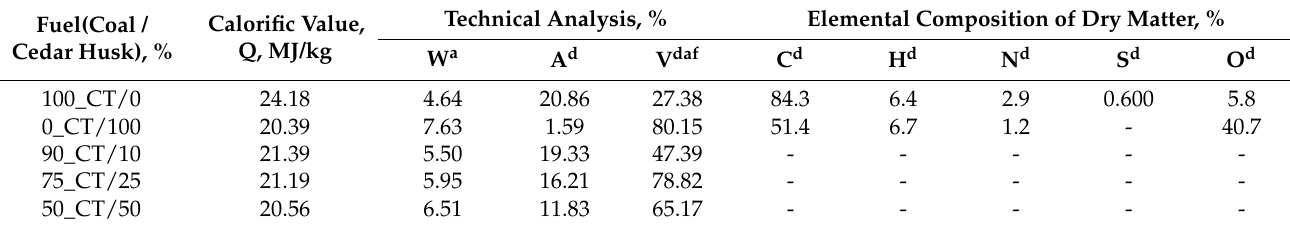
Table 1. Properties and elemental composition of fuel